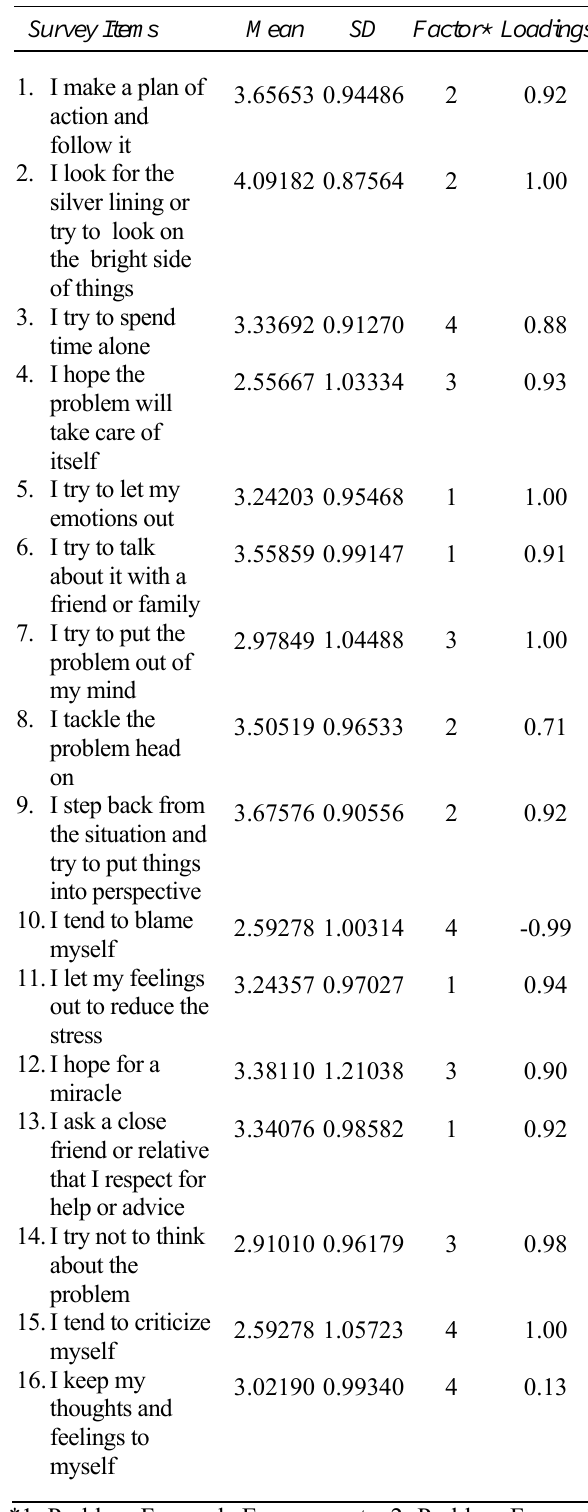
Table 4: The Survey Item Factor Loadings for the